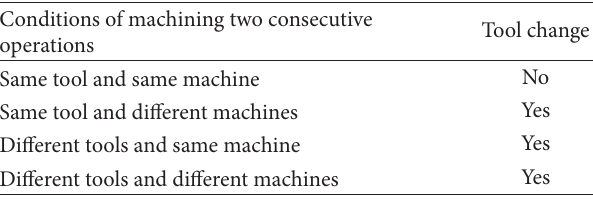
Table 3: Definition of a tool change.